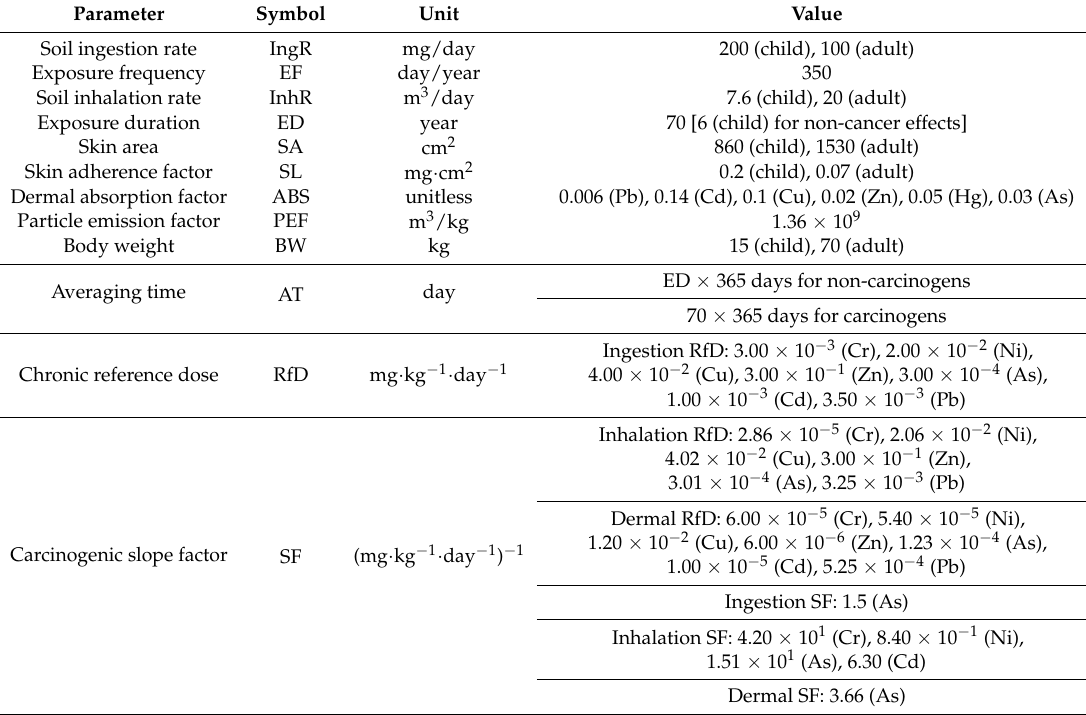
Table 1. Parameters used to evaluate the exposure risk of soil